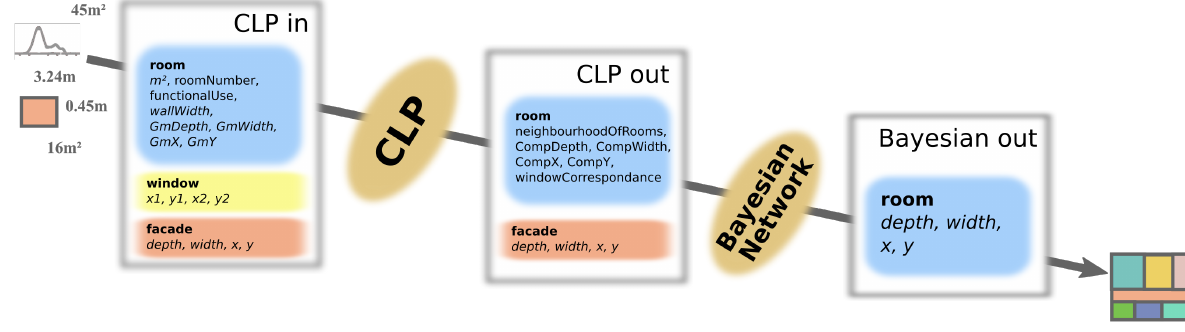
Figure 3: Workflow of the prediction and used parameters during reasoning. Gm denotes a Gaussian mixture, Comp its selected component. Continuous parameters are in italics eters that follow common architectural regularities and can be constrained by non-linear functional dependencies.